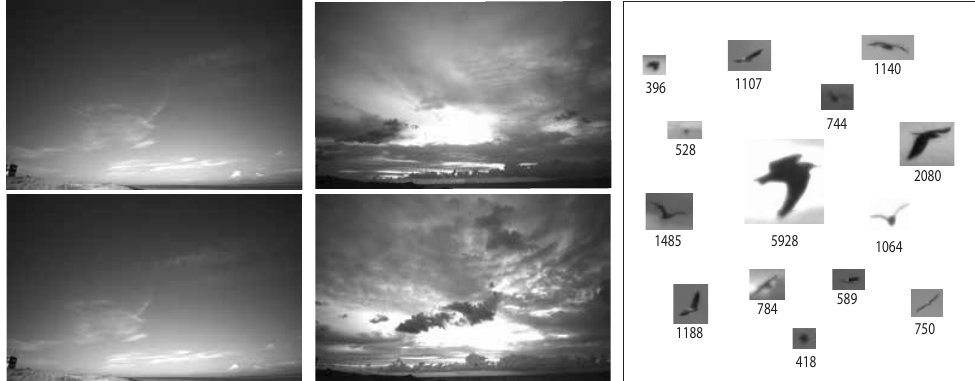
Figure 1. Frames from Skagen dataset ( left ). Klim dataset ( middle ) and examples of birds from both datasets and the corresponding pixels count for each box ( right